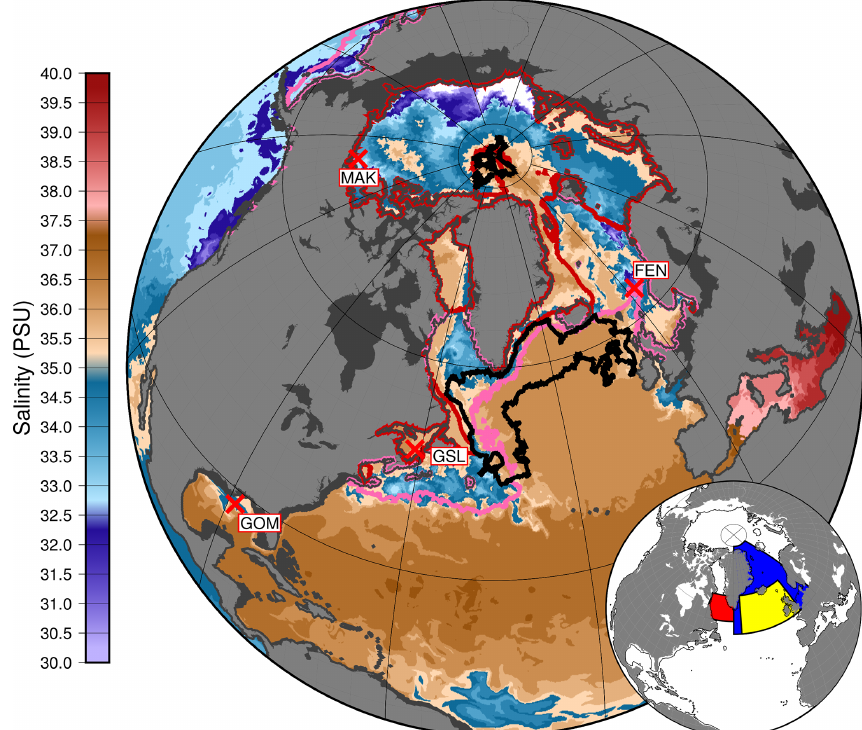
Figure 2. Sea surface salinity from a single day (i.e. daily mean data) at the end of the CBS control run. The present-day land–sea mask is shown in light grey, and the simulation land–sea mask is contoured in a darker grey. The dark-red and pink contours denote the respective minimum and maximum sea ice extent of at least 15% sea ice coverage calculated over the last 5 years of the simulation. A 1000m mixed- layer depth contour from the same time interval as the sea ice extent contours is shown in black. A comparison of the sea ice maximal extent to the mixed-layer depth is shown in Fig. S1 (for the OBS case), but the black contour in the current plot indicates that deep convection is just off the outer limit of the sea ice maximum. The strong zonality of the Gulf Stream is readily visible in the salinity field. The eddy-resolving/- permitting nature of the model configuration is evident in the plotted salinity colour bands. The inset panel shows each of the averaging regions: red represents the Labrador Sea region, blue represents the GIN seas region, and yellow represents the North Atlantic deep-water formation